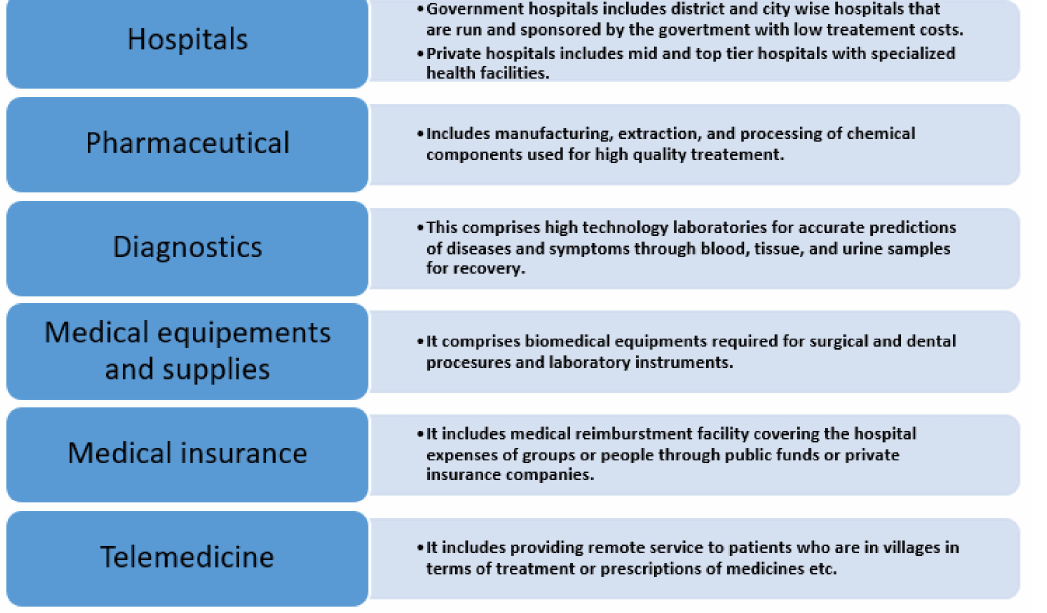
Figure 5. Segments of the Indian healthcare industry [15].